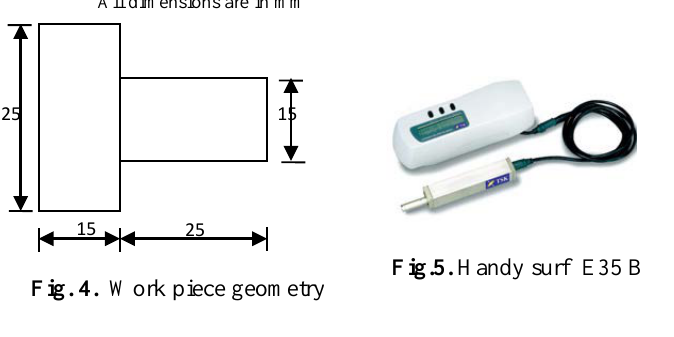
Fig. 4. Work piece geometry